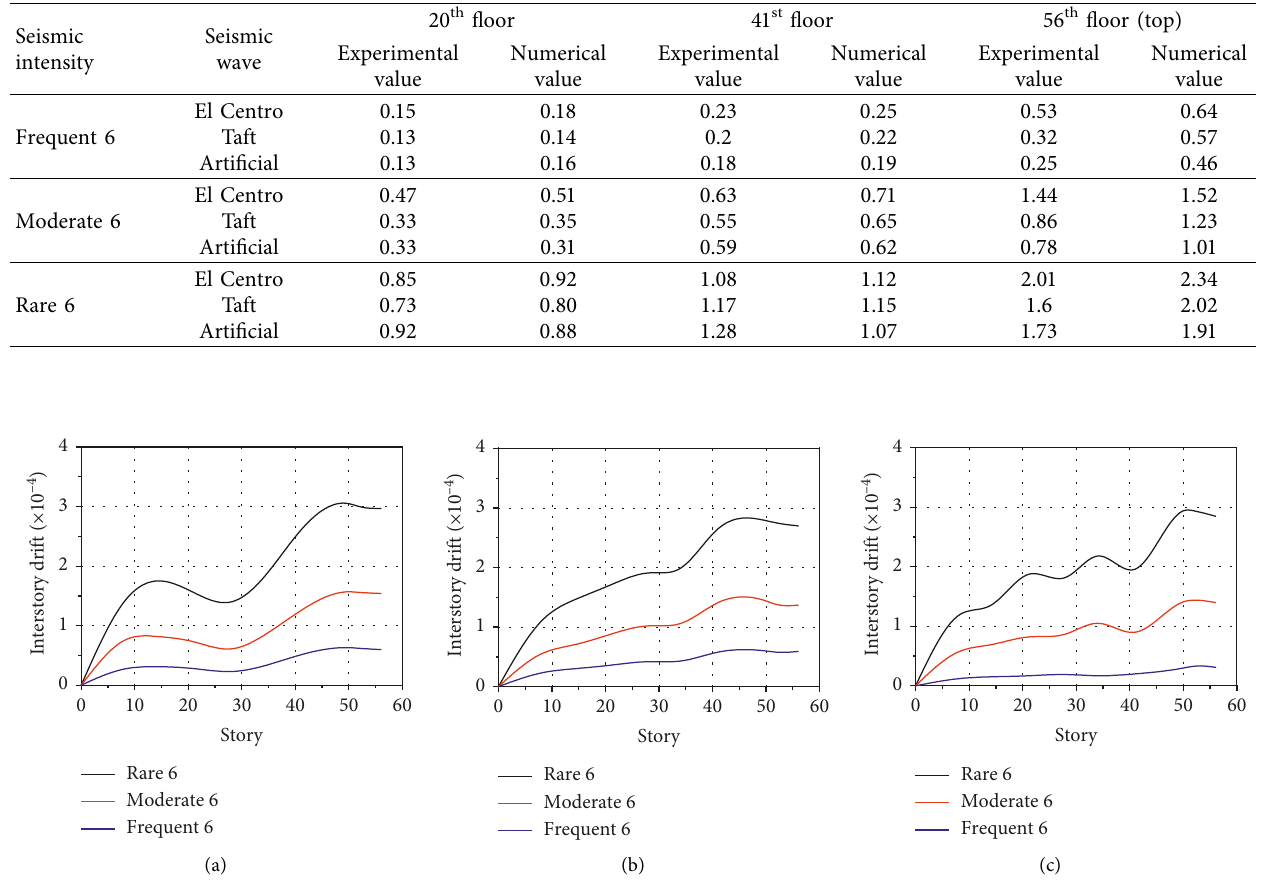
Figure 11: Envelope diagrams of story drift under different earthquake waves: (a) El Centro wave; (b) Taft wave; (c) artificial seismic wave.